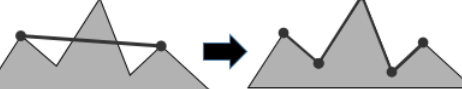
Figure 1. The Geometry-based rendering method